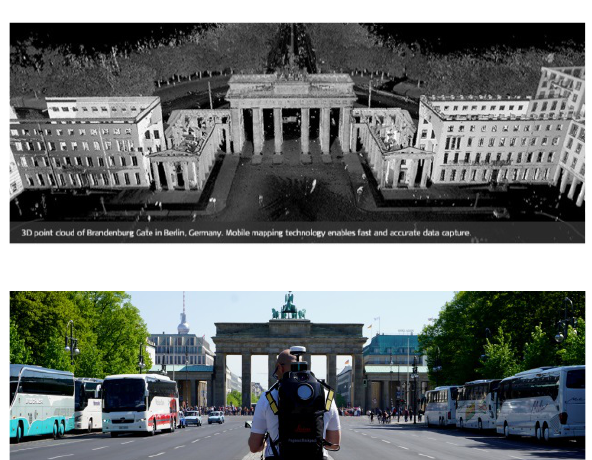
Figure 3. Backpack mobile measurement (Leica Geosystems, 2021).